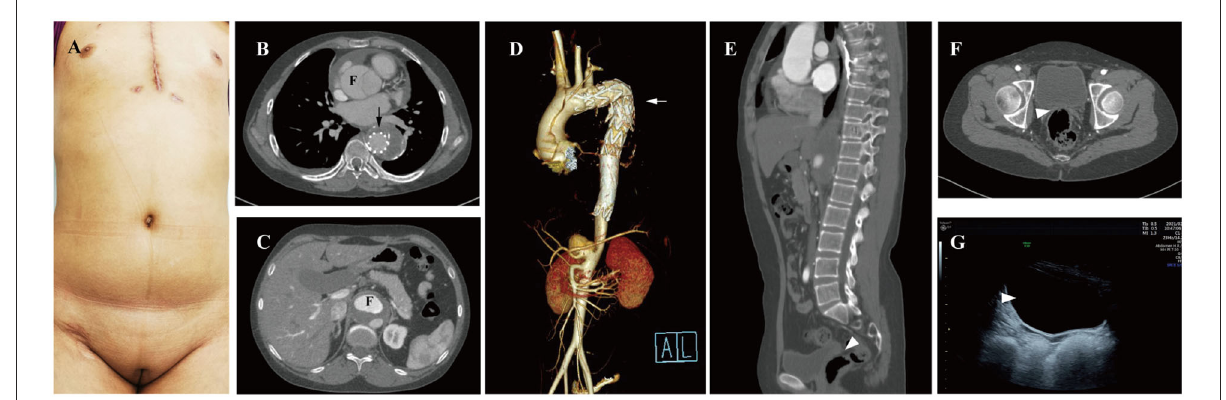
FIGURE1 Preoperative examination of the 25-year-old female patients. (A) Undeveloped secondary sexual characteristics. CTA shown aortic dissection involving the ascending (B) and abdominal aorta (C) , F, false lumen. (D) Thoracic endovascular aortic stent was grafted (arrow); no uterus or ovaries was found between urinary bladder and rectum by CTA ( E,F , arrowhead) and transabdominal ultrasound ( G , arrowhead). CTA, computed tomography angiography; F, false lumen.